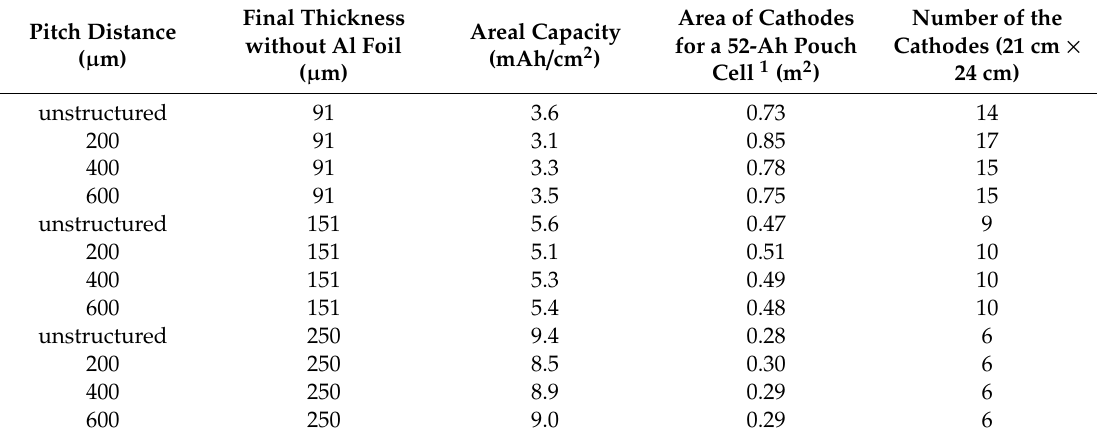
Figure 7. ( a ) Ragone plots for cells containing cathodes with different thicknesses, and ( b ) the increase of volumetric energy density of cells with structured cathodes in comparison to cells with unstructured cathodes with the same thickness at different C-rates. Table 2. The total area and quantity of NMC 622 cathodes required to fabricate a 52-Ah pouch